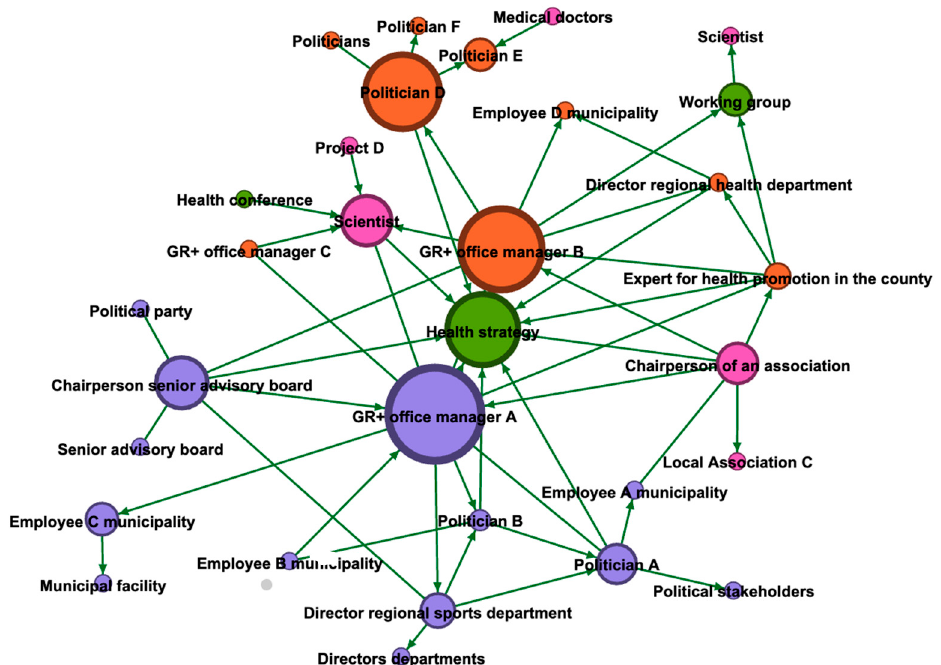
Figure 1. Map from the perspective of the project office managers. The size of the nodes displays the betweenness centrality of the actors. Orange nodes indicate actors of the county, purple nodes indicate actors of the city, pink nodes are related to actors that cannot be categorized into city/county, green nodes indicate artifacts (events, products, services, projects).